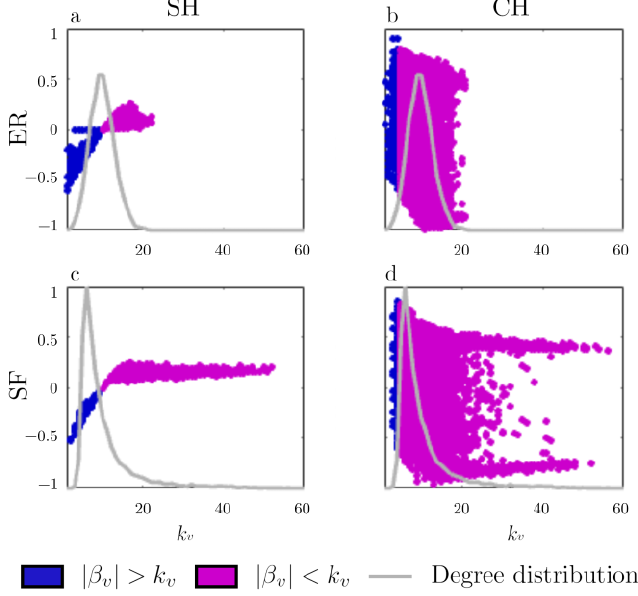
Figure 6. Altruistic and selfish behavior at steady state. The indicator c v is evaluated for SH (subplots a , c ) and CH (subplots b , d ) games in both ER (subplots a , b ) and SF (subplots c , d ) networks. β v has been set equal for all players: values of k v lower and larger than β v are reported in blue and pink colors, respectively. In the simulation, the parameters used for the SH game are: T = − 1, S = − 1 and β v = 10 ∀ v ∈ V , while the ones of the CH game are: T = 2, S = 2 and β v = − 5 ∀ v ∈ V . The numerical simulations have been performed using the build-in ODE solver ode45 explicit Runge– Kutta (4,5) of Matlab